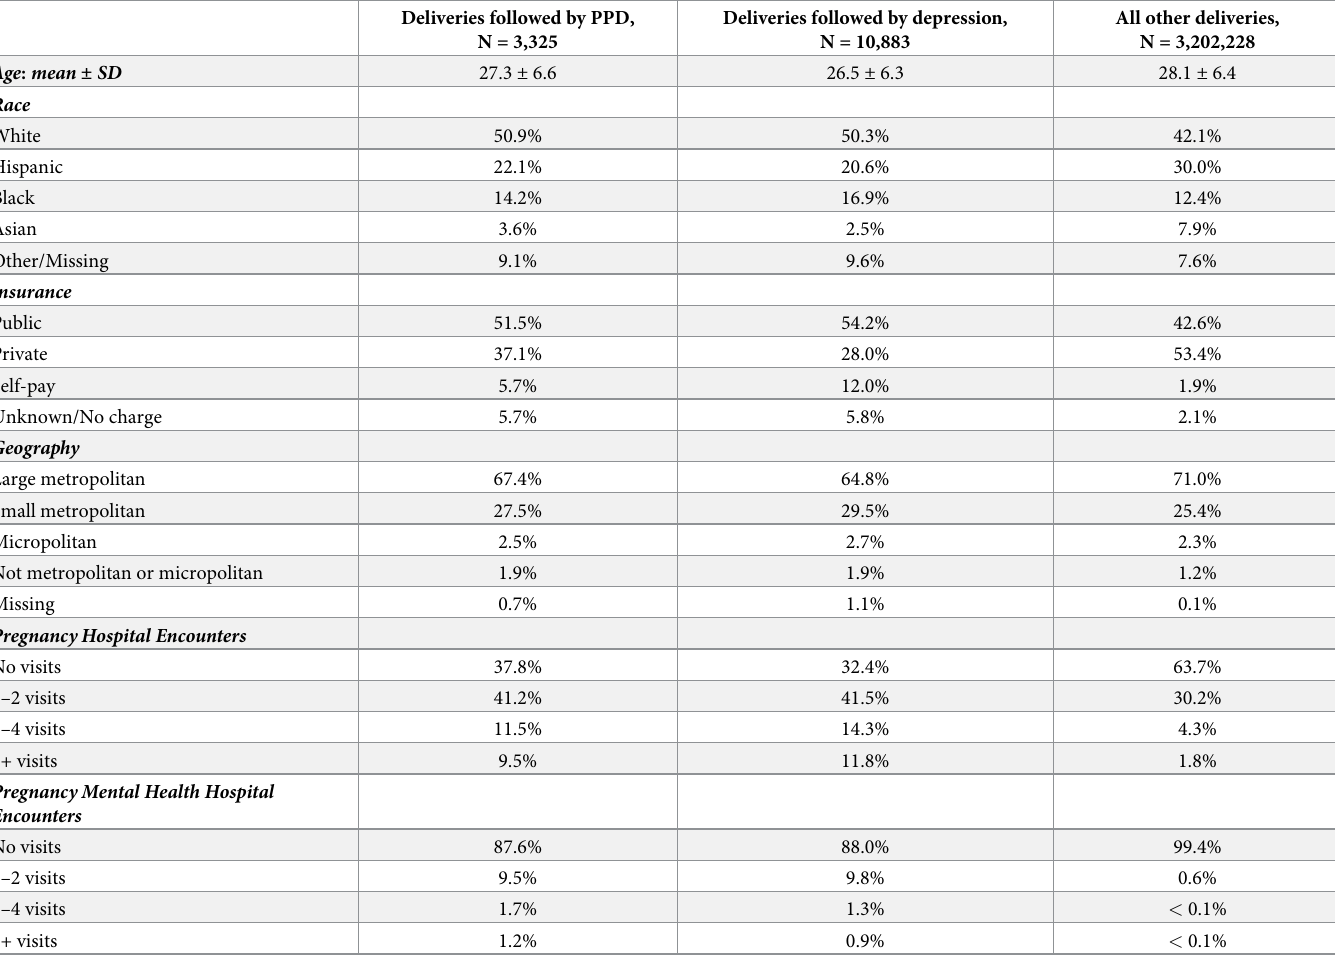
Table 1. Characteristics of the women whose deliveries were followed by at least one PPD or depression visit compared to those who were not. Deliveries followed by PPD, N =